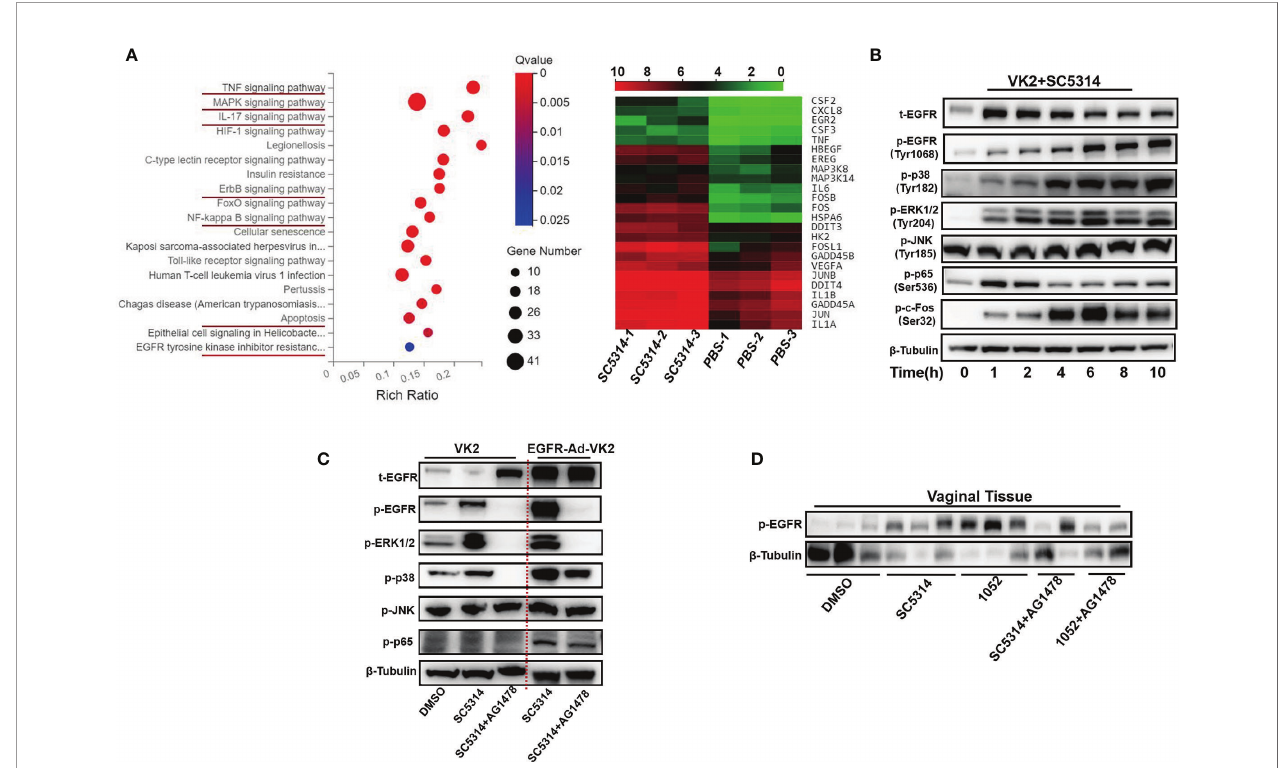
FIGURE 1 | C. albicans activates EGFR, NF- k B, MAPK and c-Fos signaling in vaginal epithelial cells. Pathway enrichment analysis and heatmaps of VK2/E6E7 vaginal epithelial cells stimulating with SC5314 and PBS. Using the phyper function in the R software to perform enrichment analysis and calculate the P value. Then performing FDR correction on the P value to obtain the Q value. A Q value < 0.05 is regarded as a signi fi cant enrichment. Red underlines highlight the upregulated pathways related to EGFR and MAPK. Heat map displaying the upregulated(red) or downregulated(blue) genes. Each column represents an individual sample(n=3) (A) . VK2/E6E7 cells were stimulated with SC5314 (MOI=5) for the indicated time. Cell lysates were analyzed by immunoblotting for the indicated proteins. The phosphorylated forms of proteins are preceded by “ p ” (B) . SC5314 elicited signi fi cantly stronger phosphorylation of p38 in EGFR-Ad-VK2, VK2/E6E7 cells overexpressing EGFR, when compared to VK2/E6E7 cells. EGFR inhibitor (AG1478) suppressed SC5314-induced phosphorylation of ERK1/2 and p38 in EGFR-Ad-VK2 and VK2/E6E7 cells (C) . Female ICR mice (n=3 or 2/each group) were infected with SC5314 or clinical isolate1052 after pre-treatment with DMSO or AG1478 for 2d and vaginal tissues were harvested 1 d after infection for detection of EGFR phosphorylation by immunoblotting analysis (D) . Data are representative of three independent experiments and bands are shown relative to b -tubulin loading